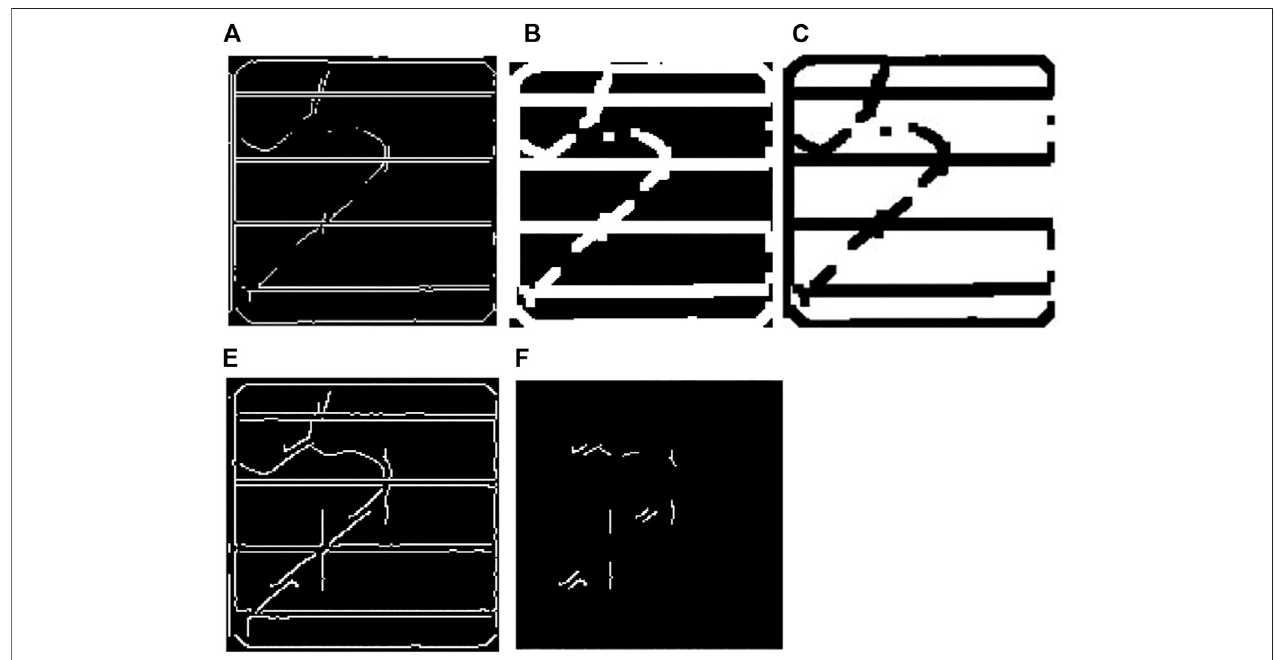
FIGURE 6 | Detection effect diagram of the algorithm in this article.